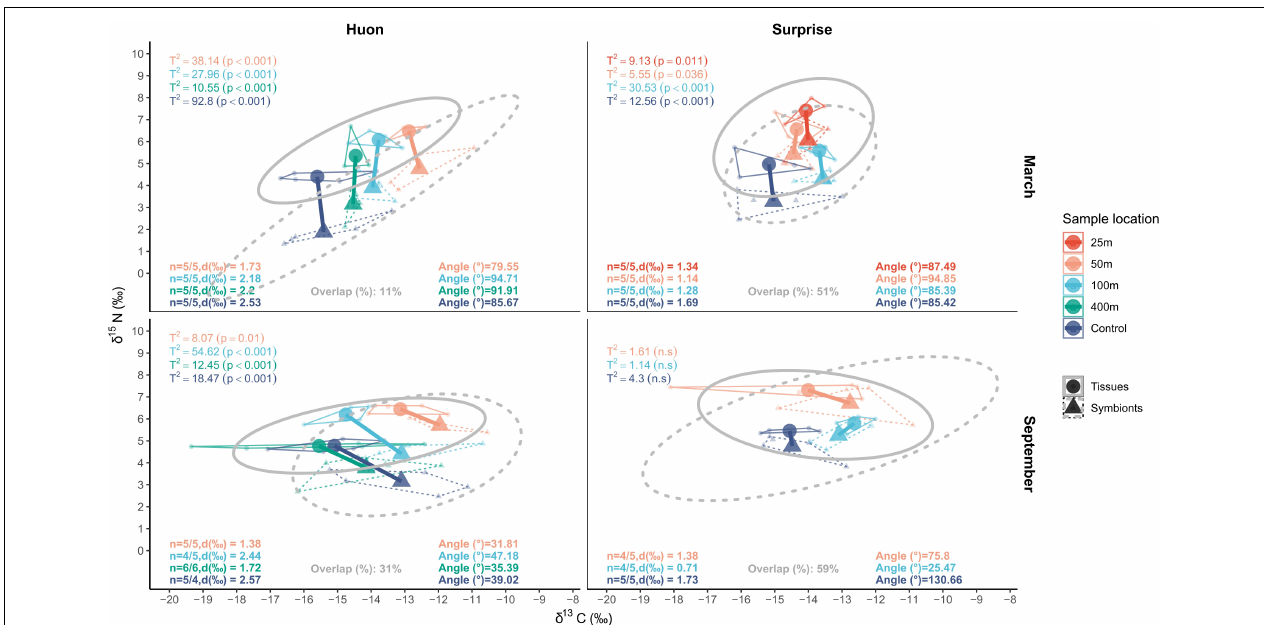
FIGURE 4 | δ 15 N and δ 13 C biplots of corals host and symbiont at each site and season. Colors represent the different transect locations. Dotted and plain lines represent the values of the tissue and symbiont fractions, respectively. The 95% SIBER ellipses are represented as well as the corresponding overlap. The colored segments represent the distance between the centroid of the two fractions, calculated at transect location resolution. Provided distances, angles, and Hotelling test values correspond to these segments.